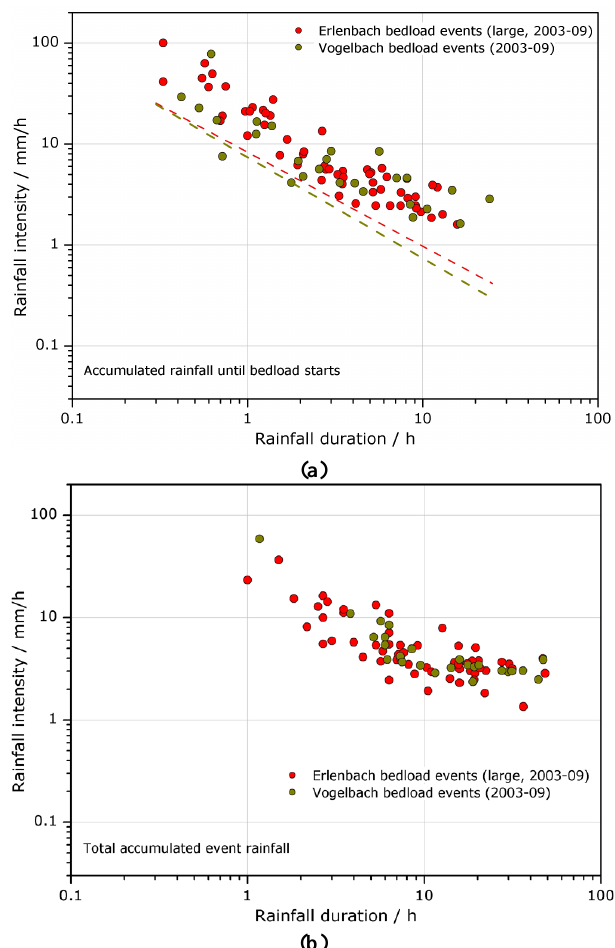
Fig. 3. (a) Intensity–duration relationship I BLS – D BLS for rainfall (recorded until beginning of bedload) that triggered large amounts of bedload in the Vogelbach (green dots) and Erlenbach (red dots) catchments during the 2003–2009 period only (cf. Table 3). The red threshold line is identical with the line in Fig. 2a (Erlenbach) whereas the green threshold line is manually fitted for the Vogel- bach data only; (b) Intensity–duration relationship I T – D T for rain- fall (recorded for the entire event) that triggered large amounts of bedload transport in the Erlenbach (red dots) and the Vogelbach (green dots) catchments during the 2003–2009